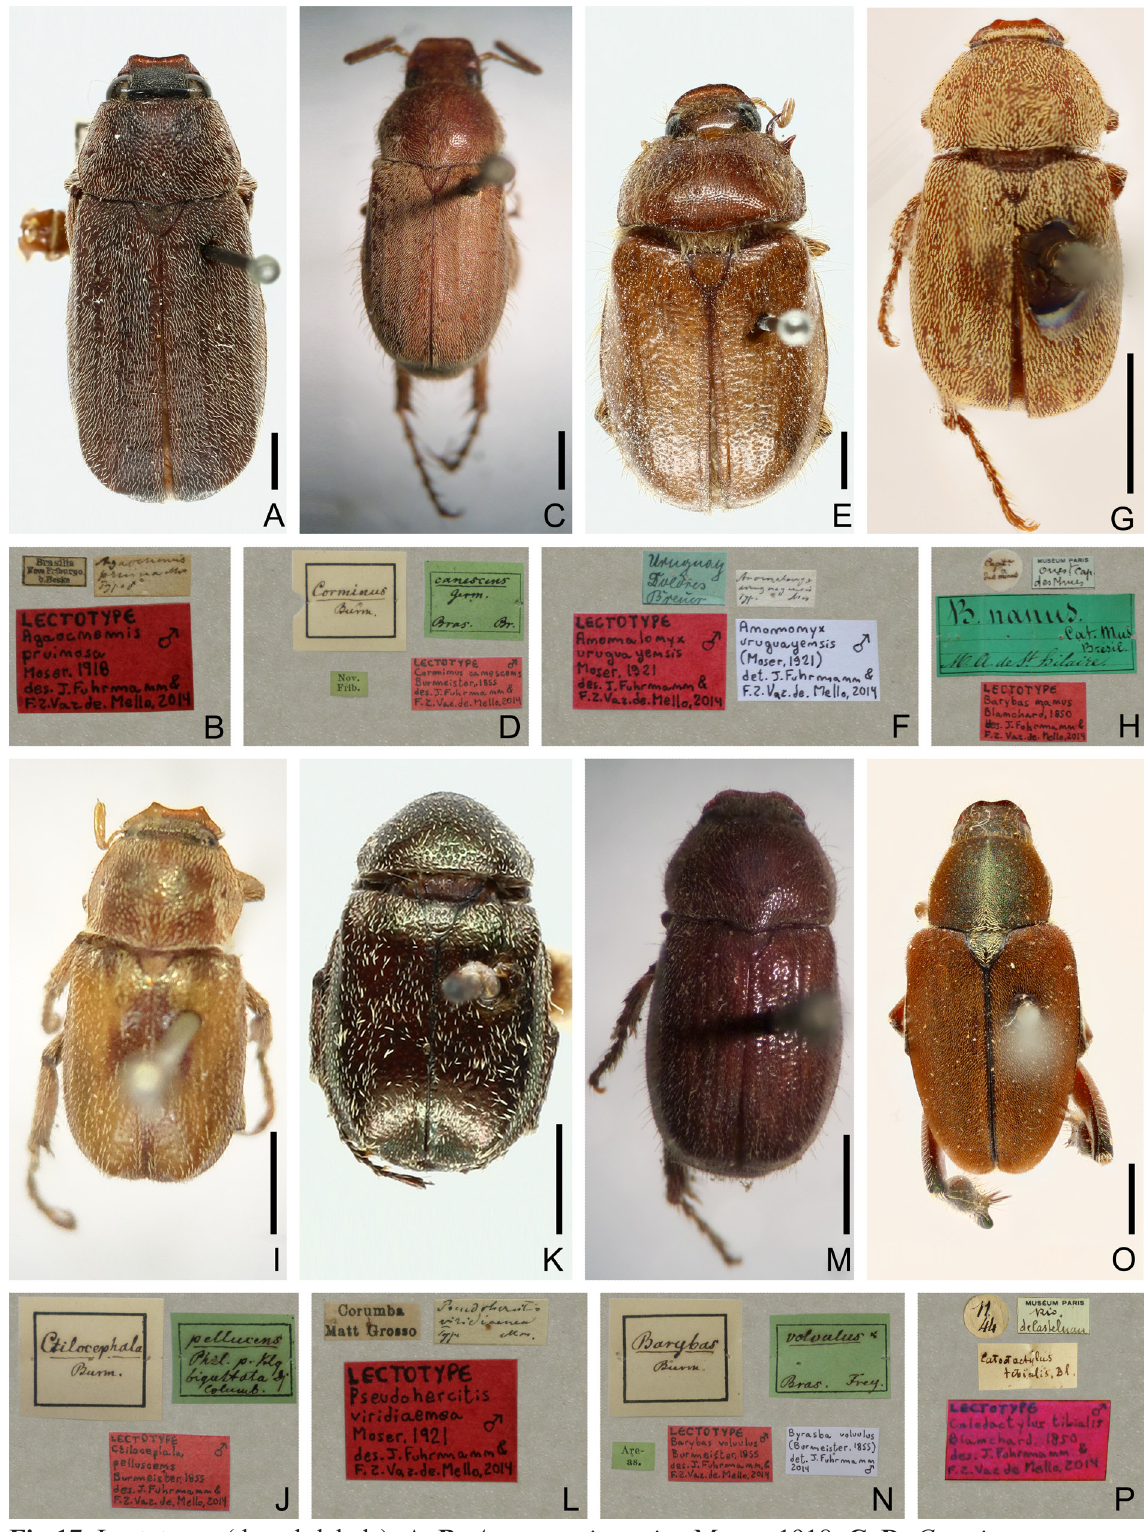
Fig 17. Lectotypes (dorsal, labels). A–B . Agaocnemis pruina Moser, 1918. C–D . Corminus